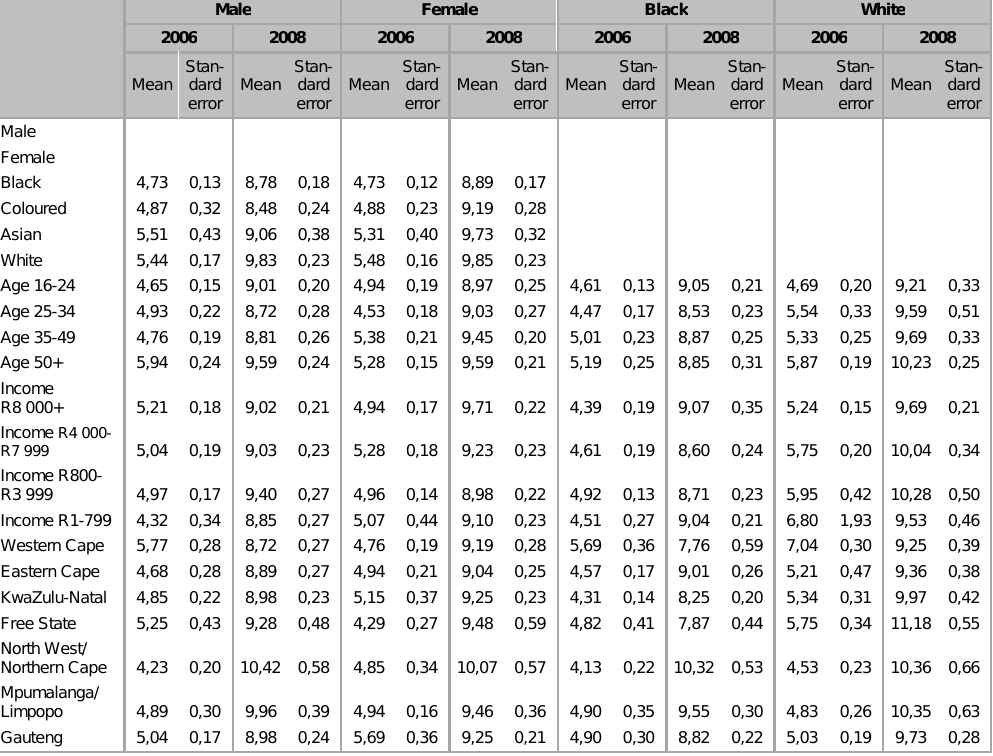
Average of responses about inflation expectations according to gender, and black and whites, 4 th quarter 2006 and